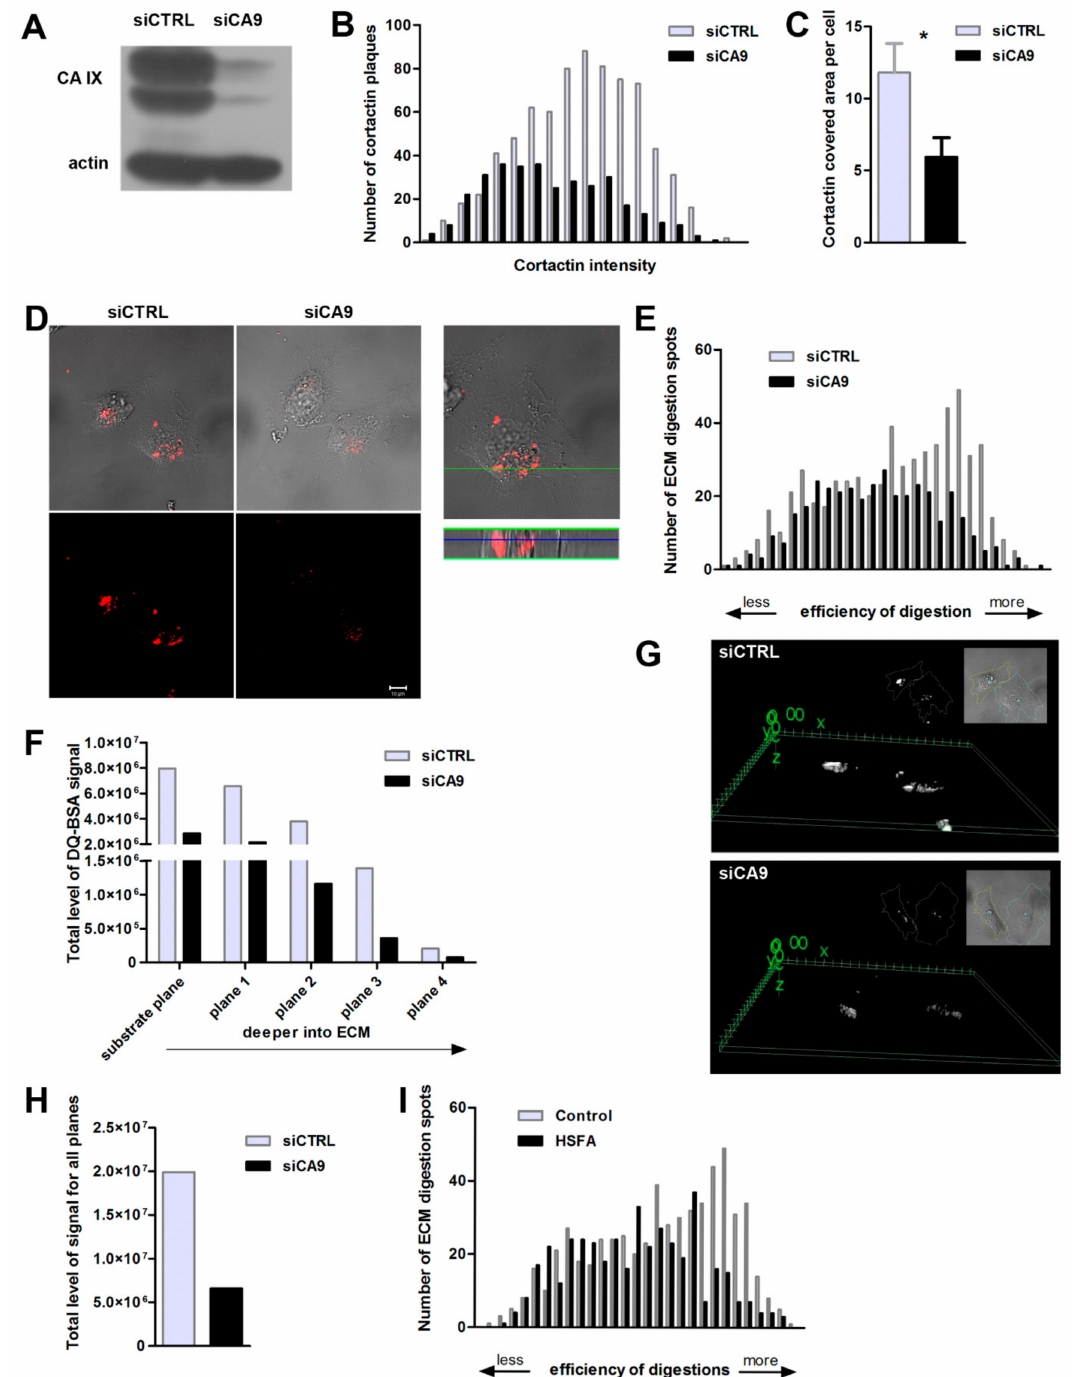
Figure 3. CAIX expression promotes invadopodia formation and increases the e ffi ciency of extracellular matrix digestion. ( A ) Representative Western blot proving a high e ffi ciency of transient CA9 silencing in hypoxia-cultured HT1080 cancer cells. ( B ) Hypoxic CA9-attenuated (siCA9) and control CAIX expressing (siCTRL) HT1080 cells were grown for 5 h on FITC-collagen which allowed us to define the plane of the substrate. Samples were fixed and fluorescently stained for cortactin (N = 23 cells, in two independent experiments). CAIX expressing cells (siCTRL) show a higher number of cortactin-containing invadopodia characterized by stronger fluorescent intensity in comparison to CA9-suppressed cells (siCA9). These results indicate a stimulating role of CAIX in the cortactin accumulation during the invadopodia precursor assembly. ( C ) Analysis of the overall area covered by cortactin-containing invadopodia in individual cells. The graph shows mean ± stdev of